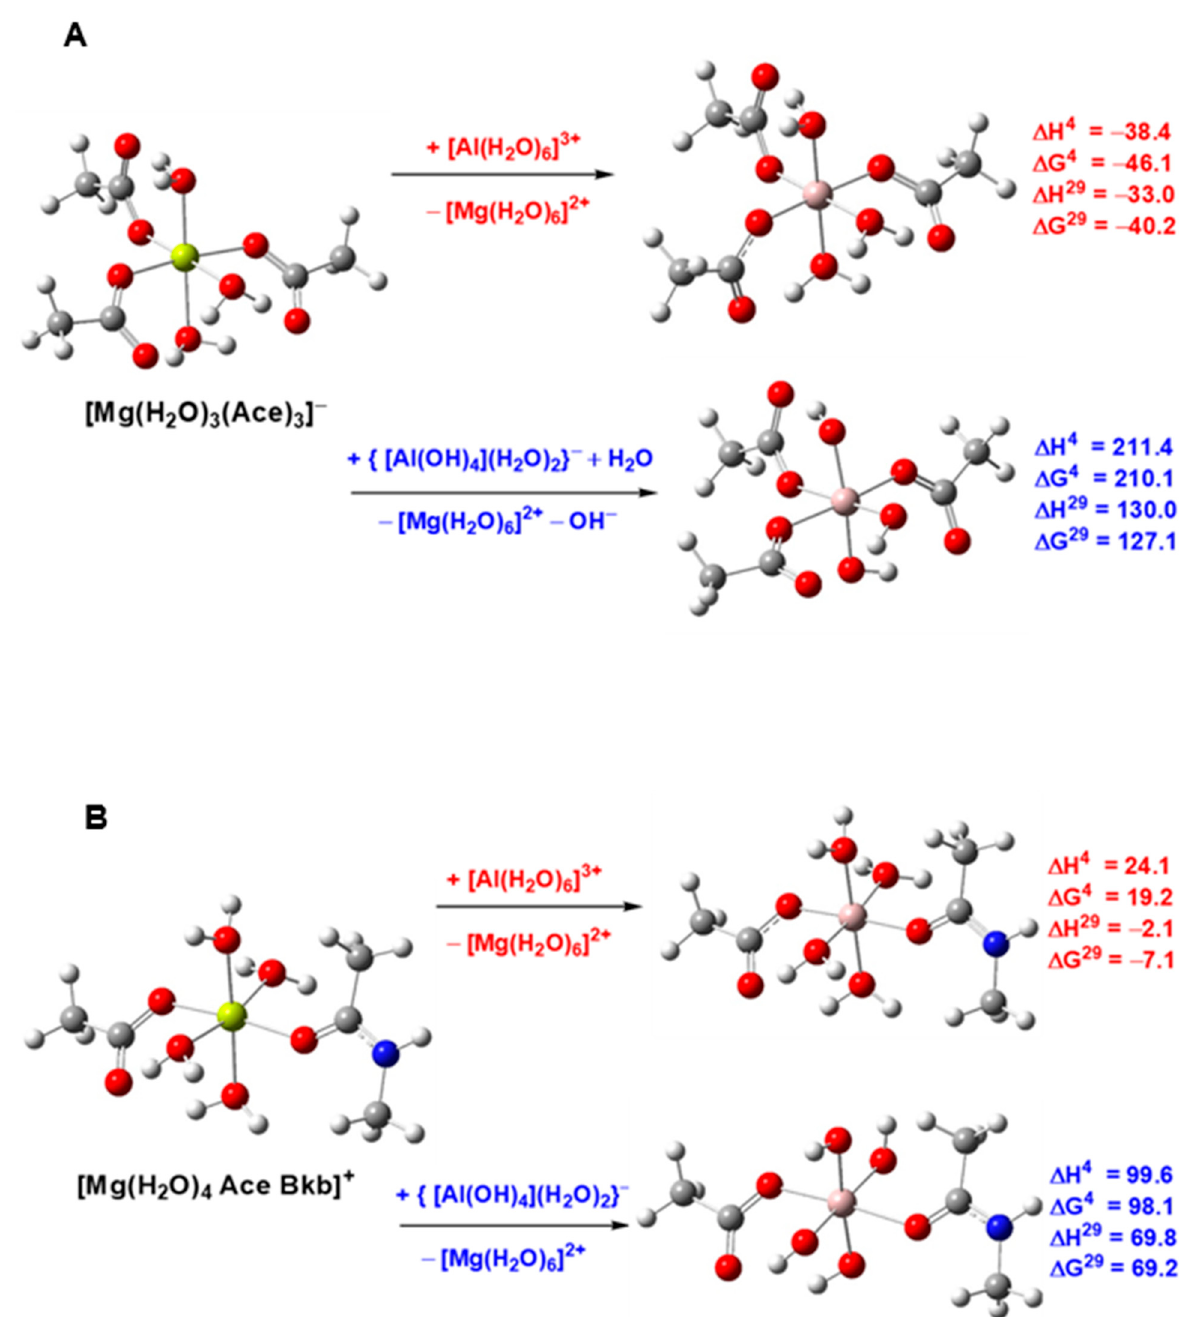
Figure 8. M06-2X/6-311++G** optimized structures of Mg 2+ model binding sites comprising ( A ) three acetates and three water ligands, and ( B ) one acetate, one N-methylacetamide and four water ligands, and the respective resultant Al 3+ -containing structures obtained via Mg 2+ → [Al(H 2 O) 6 ] 3+ and Mg 2+ → {[Al(OH − ) 4 ](H 2 O) 2 } − substitution. The enthalpies, Δ H ε , and Gibbs free energies, Δ G ε (in kcal/mol), for replacing Mg 2+ with Al 3+ in the binding site characterized by dielectric constant ε are shown on the right and colored in red for the Mg 2+ → [ Al(H 2 O) 6 ] 3+ reaction, and in blue for the Mg 2+ → {[Al(OH − ) 4 ](H 2 O) 2 } − reaction. Δ H 4 / Δ G 4 and Δ H 29 / Δ G 29 refer to cation exchange enthalpy/free energy in an environment characterized by an effective dielectric constant of 4 and 29, respectively. Positive free energies imply a magnesium ‐ selective binding site, whereas negative free energies suggest otherwise. Color scheme—Mg: yellow, Al: pink, O: red, N: blue, C: grey, H:slight grey. Adapted from Ref. [78]. Copyright 2018 Springer.